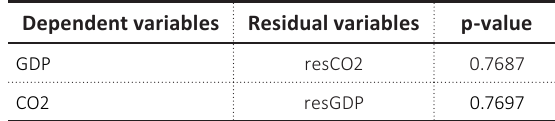
Table 4. Hausman specification test